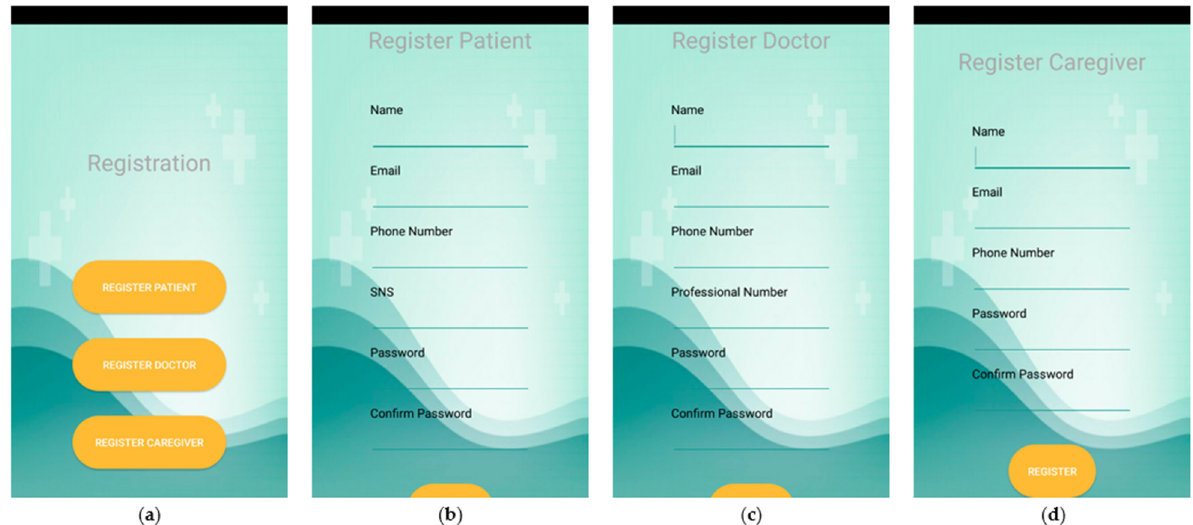
Figure 5. Sign Up. Figure ( a ) shows the registration menu that allows for the registration of a patient in Figure ( b ), the registration of a doctor in Figure ( c ), and the registration of a caregiver in Figure ( d ).